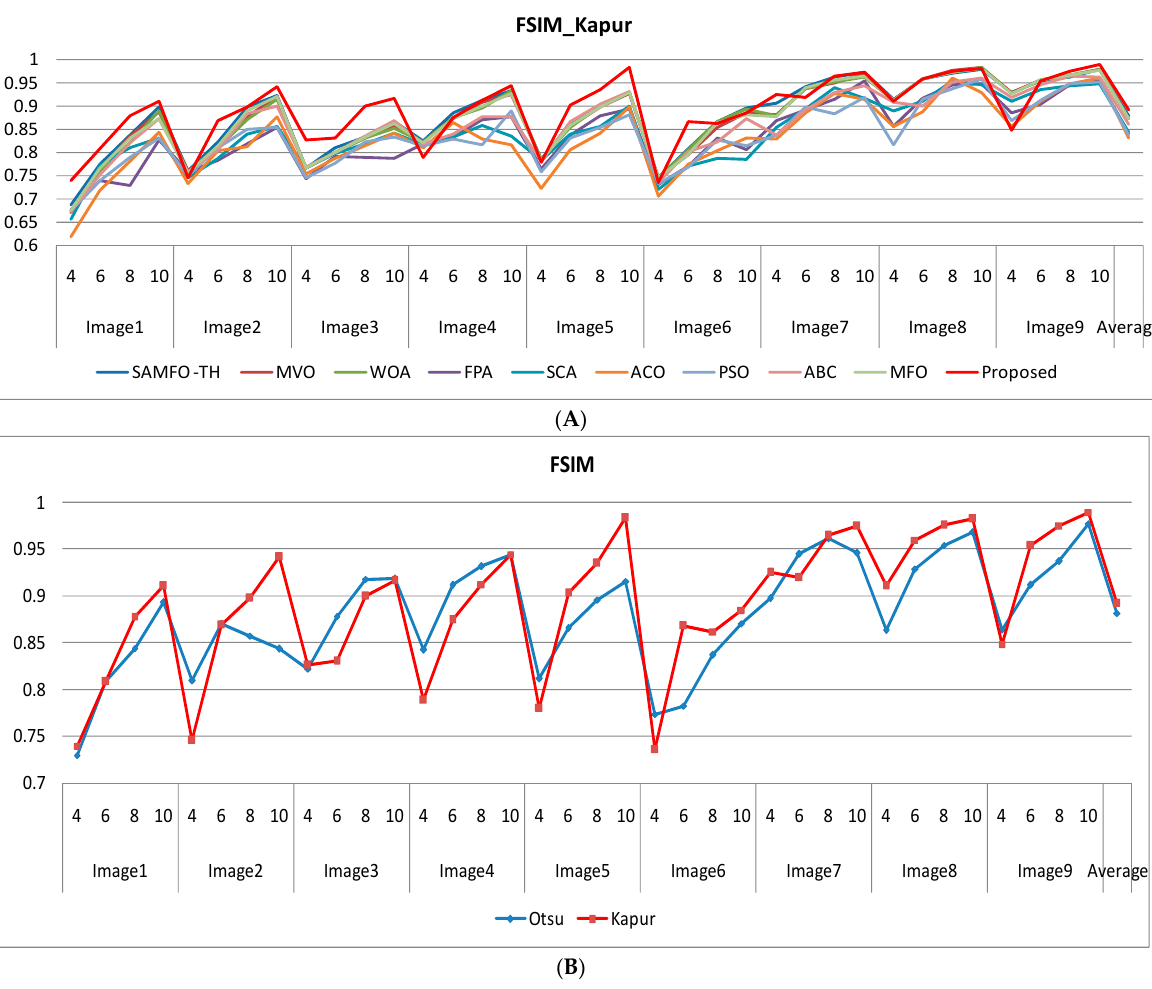
Figure 12. ( A ) Comparison of PSNR based on Kapur’s method. ( B ) Comparison of FSIM with the proposed method based on Otsu’s and Kapur’scriteria.